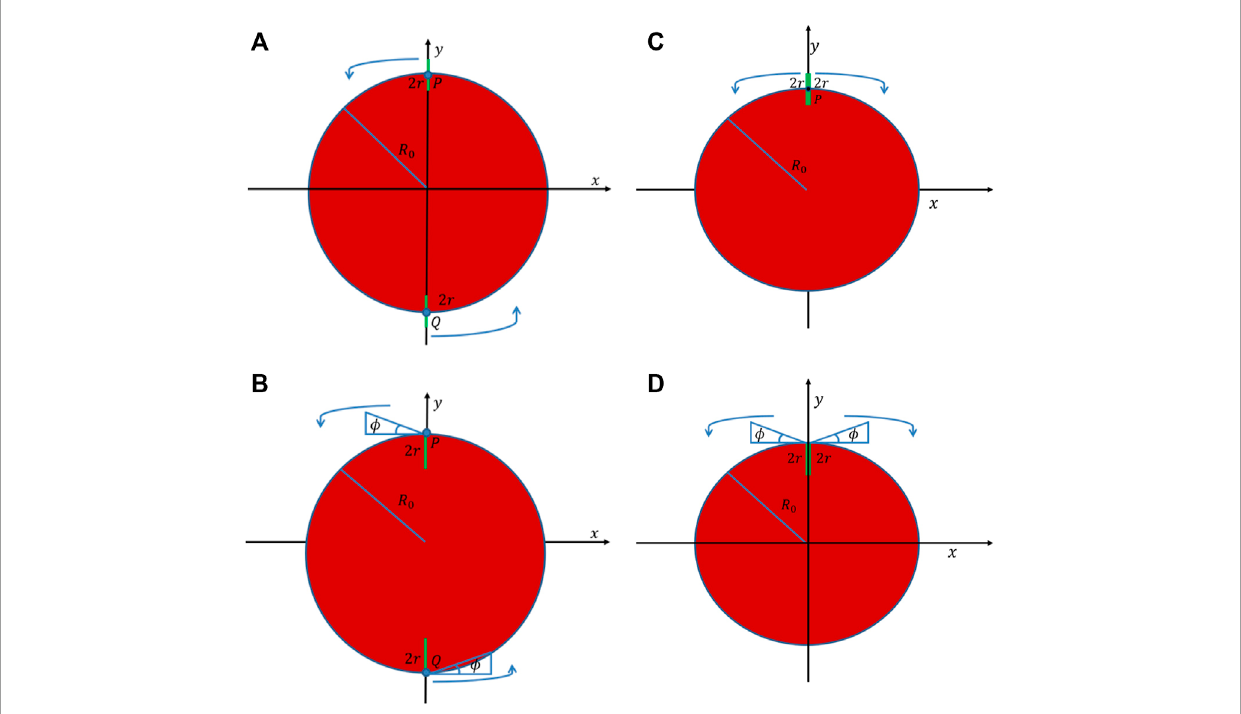
FIGURE 2 (A) —Initial placement of two agents employing the same-direction circular sweep process. (B) —Initial placement of 2 agents employing the same-direction spiral sweep process. (C) —Initial placement of 2 agents employing the circular pincer sweep process. (D) —Initial placement of 2 agents employing the spiral pincer sweep process. The sweepers sensors are shown in green. The angle ϕ is the angle between the tip of a sweeper’s sensor and the normal of the evader region. ϕ is an angle that depends on the ratio between the sweeper and evader